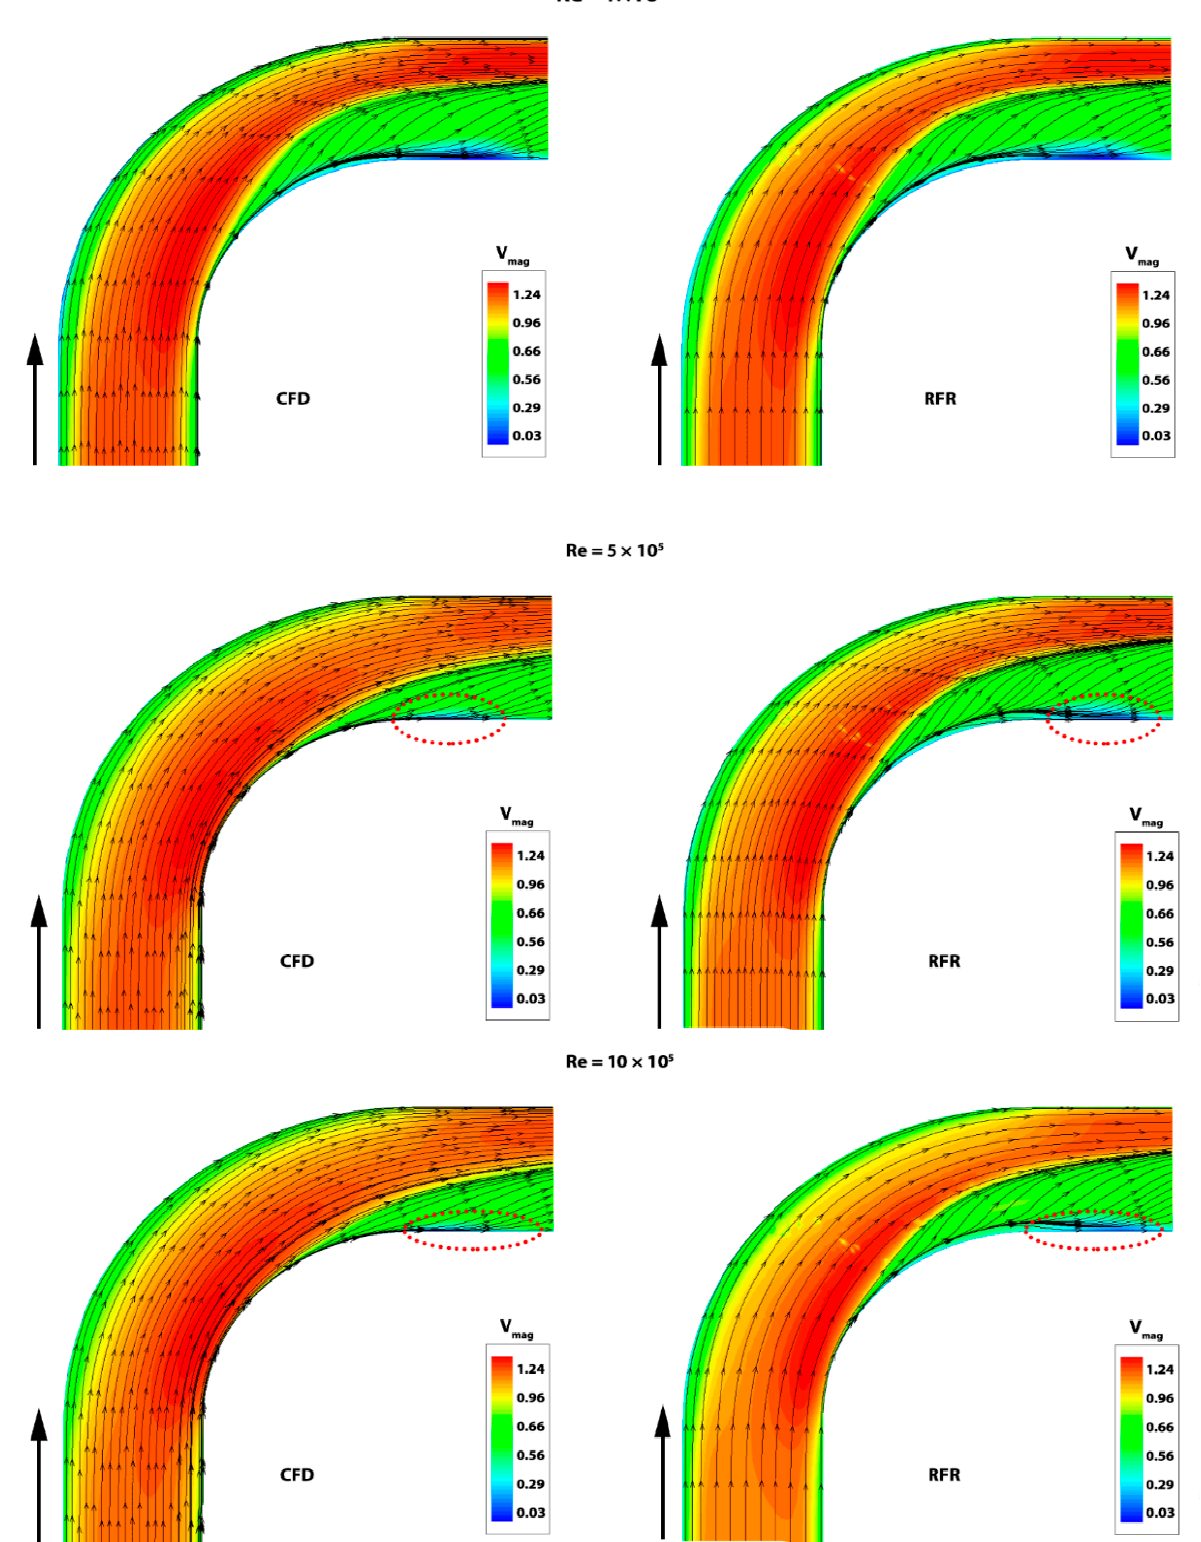
Figure 7. Flow structure at central cross-section of the bend for different Re. ( left section : CFD result; right section : RFR result). The oval shaped red dotted lines indicate the region in which maximum discrepancy in CFD and RFR results is observed.